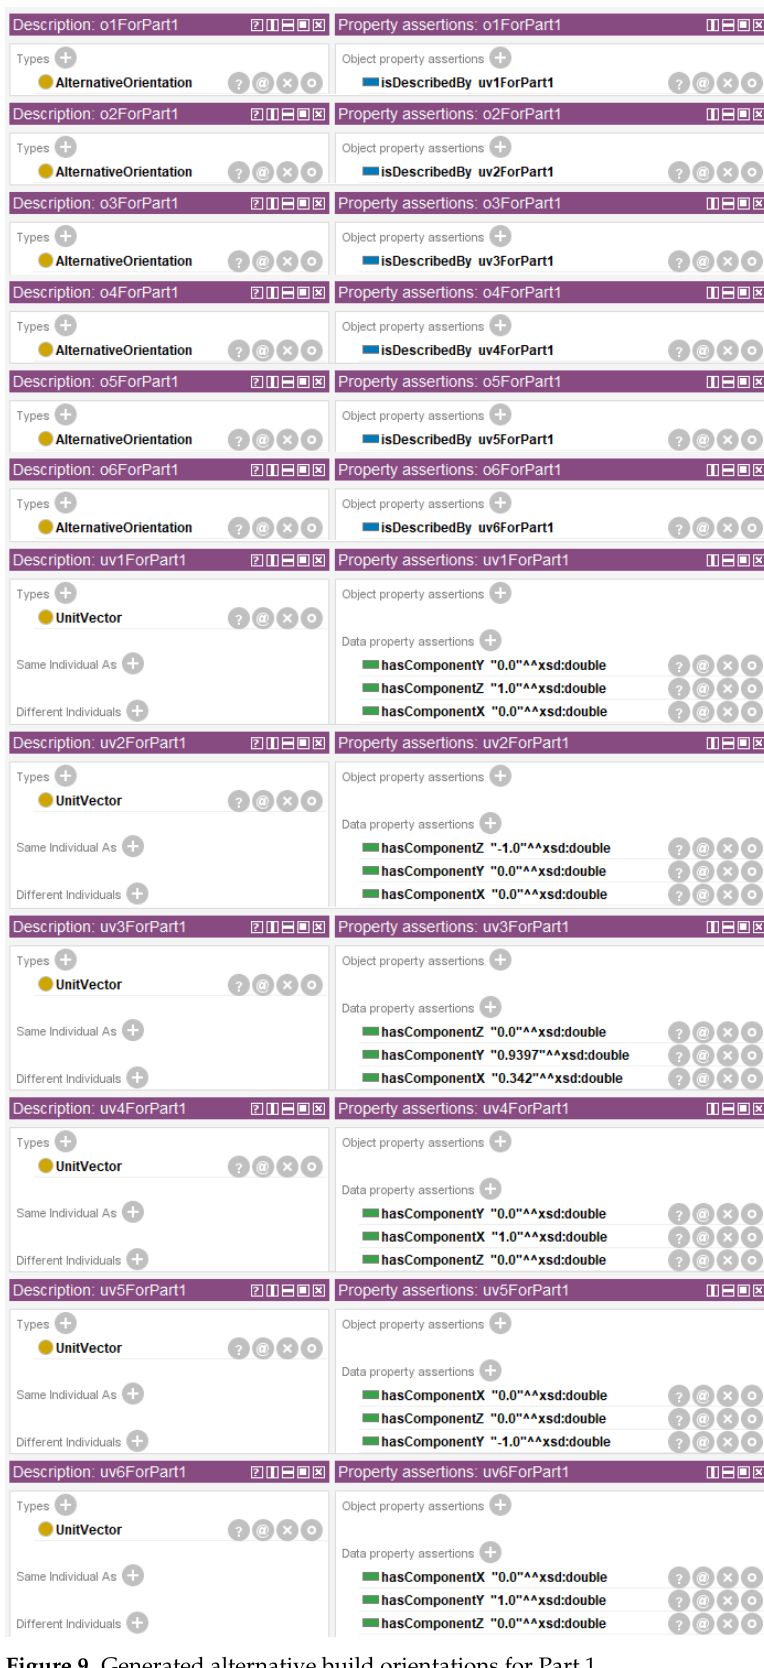
Figure 9. Generated alternative build orientations for Part